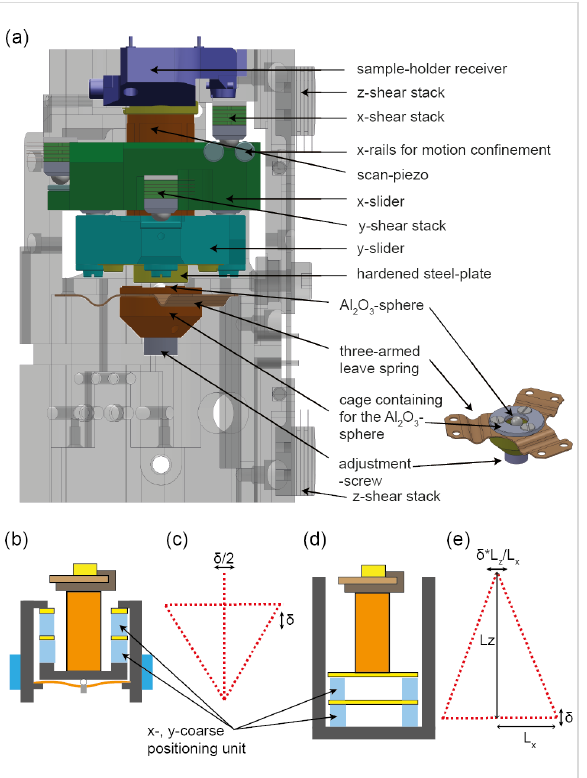
Figure 5: (a) CAD drawing of the z-positioning unit containing the xy-positioning units with scan piezo and, mounted to it, the sample holder receiver. (b) Schematic drawing of the assembly depicted in (a) highlighting the concentrical design and (c) the corresponding stability triangle. (d) Schematic drawing of a more conventional design, where the scan piezo is mounted on the top of the xy-positioning unit and (e) the corresponding stability triangle.